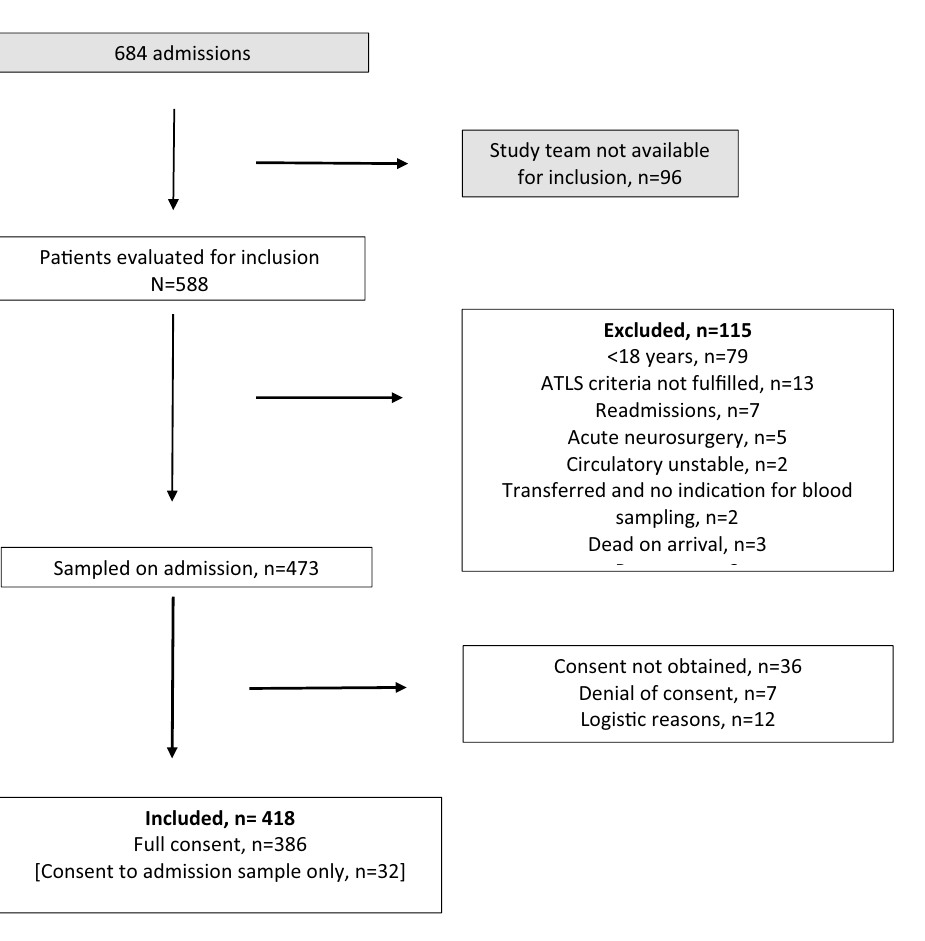
Figure 1. Study inclusion and selection